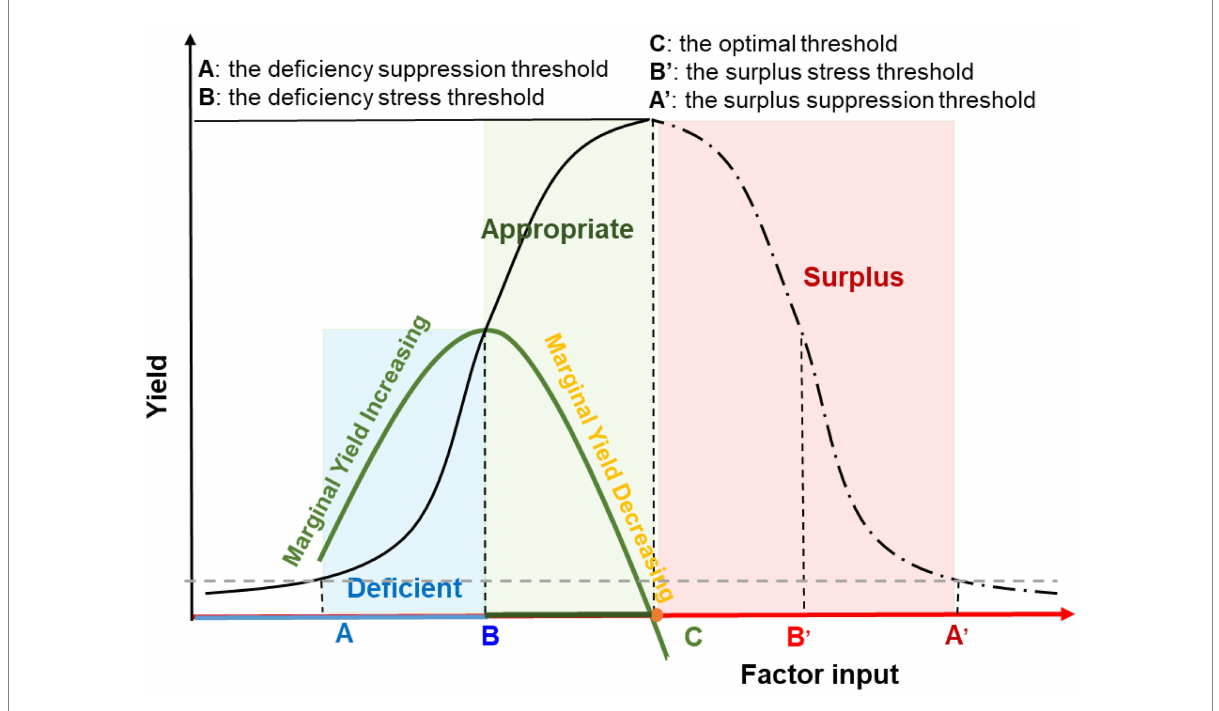
FIGURE 2 Schematic diagram of the climatic threshold of crop